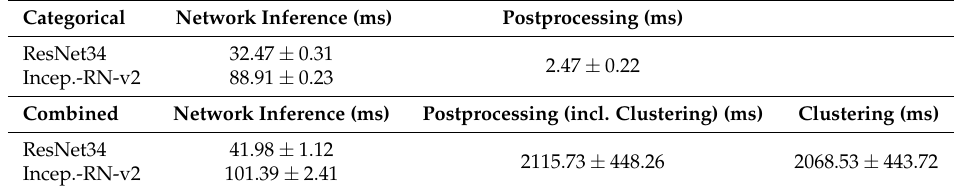
Table 5. Runtime evaluation of the proposed experiments for categorical segmentation and combined instance segmentation: All values are given as mean runtime and standard deviation over the 226 images of the test set.